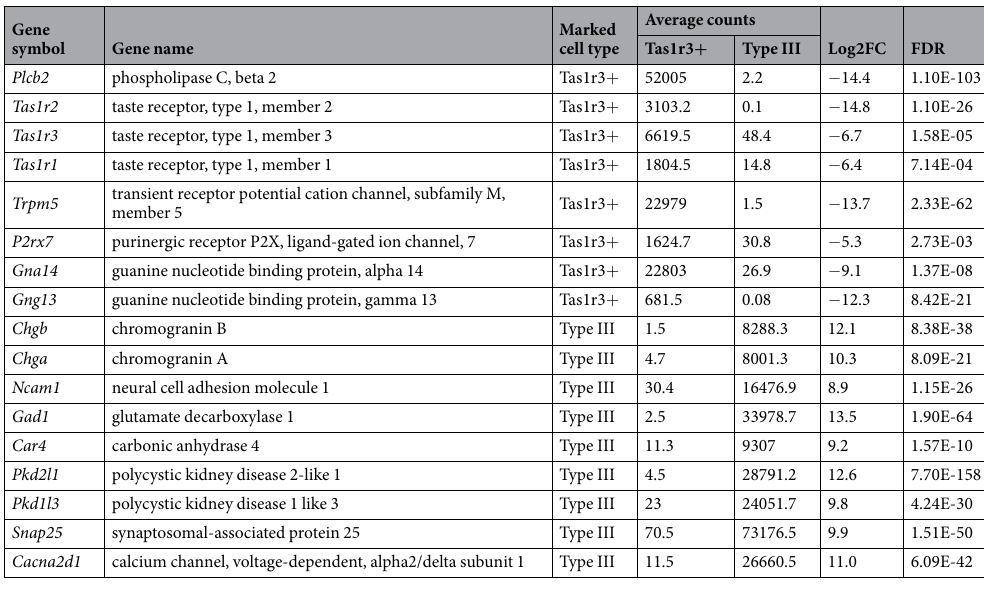
Table 1. RNA-Seq data for genes known to be selectively expressed by Tas1r3 + and type III taste cells based on evidence from the literature. “Marked cell type” = a cell type where the gene is reported to be